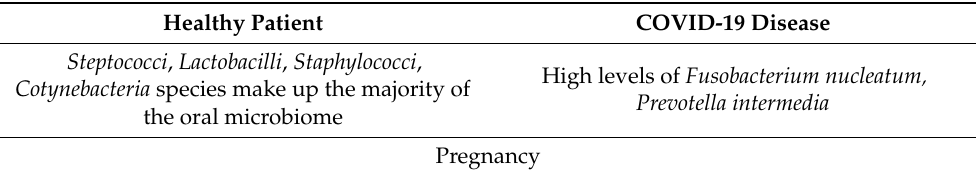
Table 3. The bacterial species that comprise the oral microbiome of a healthy patient, a pregnant patient and a COVID-19 patient. Healthy